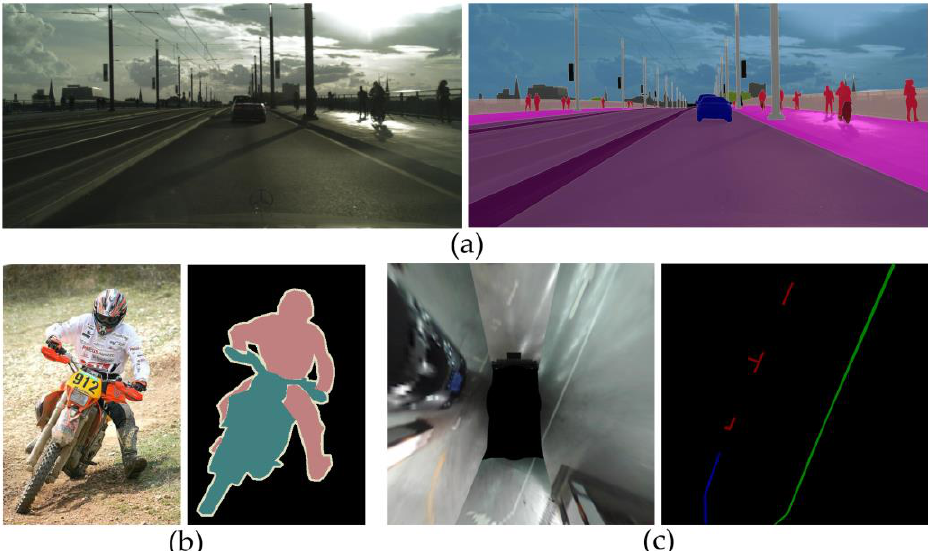
Figure 1. Multi-dataset image content comparison. In this figure, the general semantic segmentation datasets: ( a ) Cityscapes; ( b ) Pascal VOC2012; and ( c ) the PSV parking slot detection dataset used in this study are shown, respectively. In the Cityscapes and Pascal VOC2012 datasets, the labeled ground truth parts account for most of the entire image. However, in the PSV dataset, most of the images are background and only small parts are labeled.